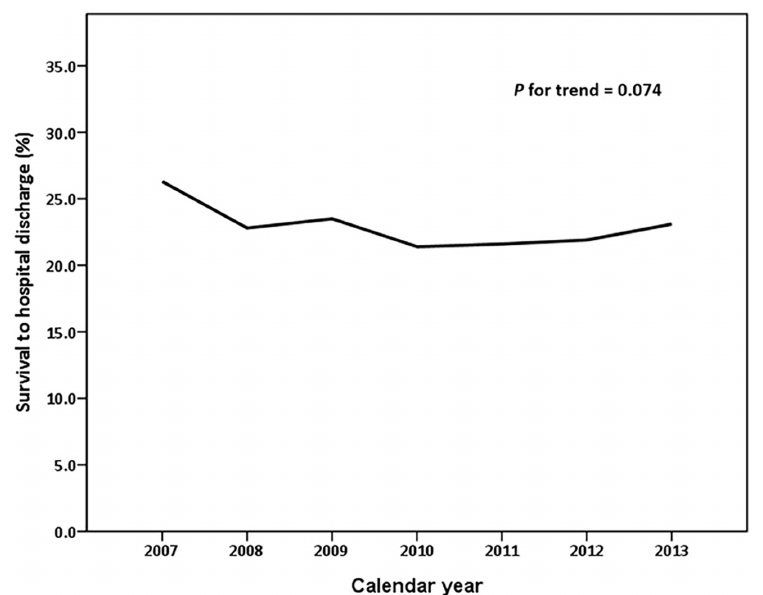
Fig 1. Temporal trend of survival to hospital discharge among hospitalized out-of-hospital cardiac arrest